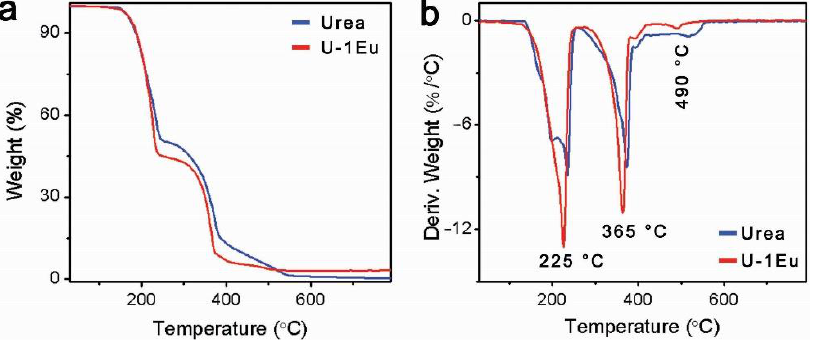
Figure 3. ( a ) TG and ( b ) DTG curves of urea and U-1Eu.